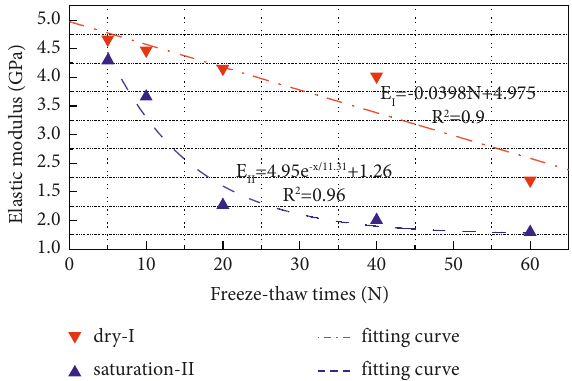
Figure 4: Fitting curve of elastic modulus of sandstone with different moisture contents with F-T